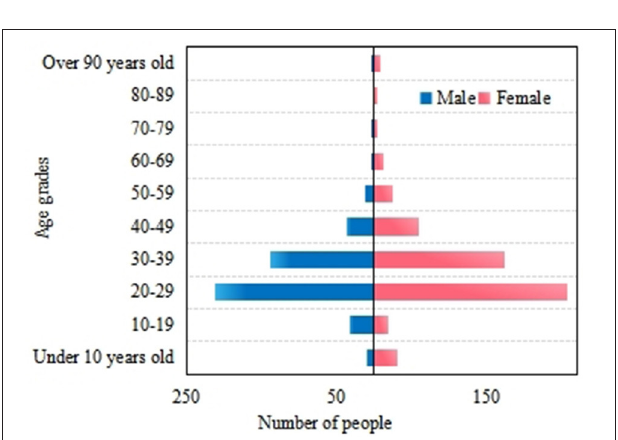
FIGURE 2 | Sex- age structure of the disseminators of short fitness videos on